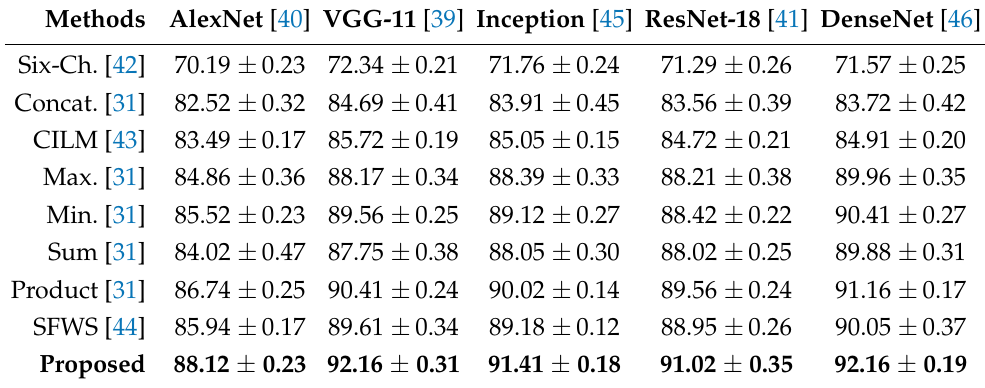
Table 5. Classification accuracy (%) ± STD using different fusion methods on